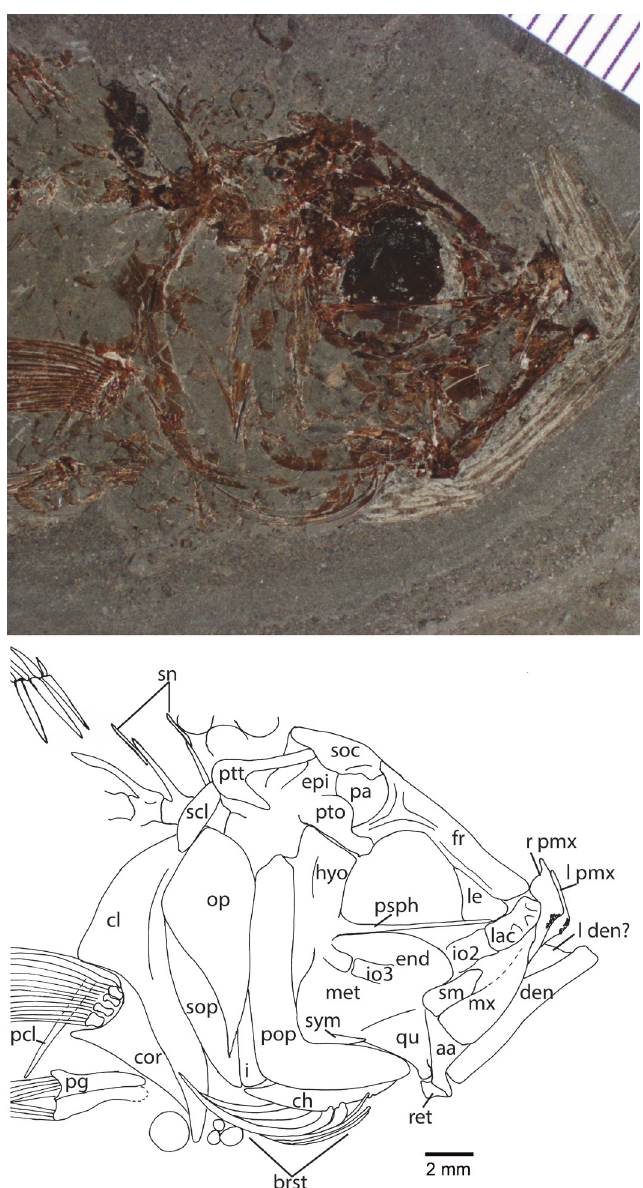
Figure 3. Cumbaaichthys oxyrhynchus gen. et sp. nov., UALVP 56113. Top, Photograph of the head, pectoral and pelvic girdles under polarized light; bottom, interpretive drawing. Scale bar equals 2